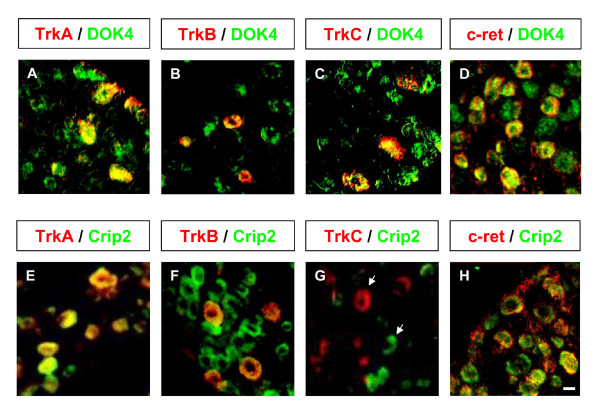
Co-localisation of Crip2 and Dok4 mRNAs with defined sub-populations of sensory neurons: Double in situ hybridization was carried out by using fluorescein/fast red detection for TrkA (A, E), TrkB (B, F), TrkC (C, G), c-ret (D, H) and DIG/NBT-BCIP for Dok4 (A, B, C, D) and Crip2 (E, F, G, H). In situ signals were converted into pseudo colors and images were superimposed to show co-labelling of cells. Dok4 co-localised with all major subtypes of DRG neurons, Crip2 was specifically excluded from TrkC population. Scale bar 50 μm.